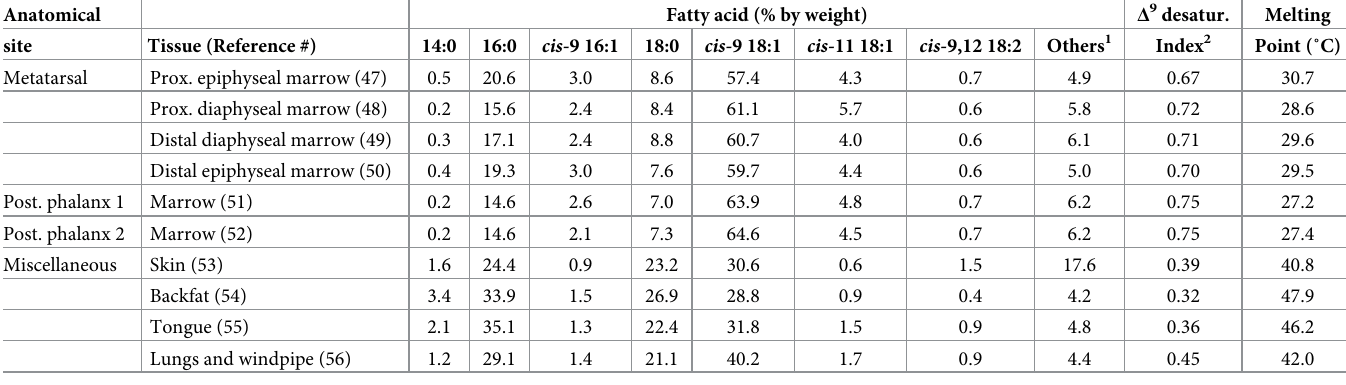
A comparison of the limbs with the axial skeleton shows several interesting patterns. In muscle tissues, values for the Δ 9 desaturase index are systematically lower in the body core (tongue to sternum: 0.360 ± .011, n = 6) than the limbs (scapula, pelvis and long bones: 0.486 ± .041, n = 6, Fig 6A), a trend also observed in cancellous marrow (cervical to sternum: 0.332 ± .021, n = 5; scapula, pelvis and limb bones: 0.559 ± .132, n = 16, Fig 6B). We note that the per- centage of short chain saturated FA (Fig 6C) and the n-6/n-3 ratio (Fig 6D) are higher in